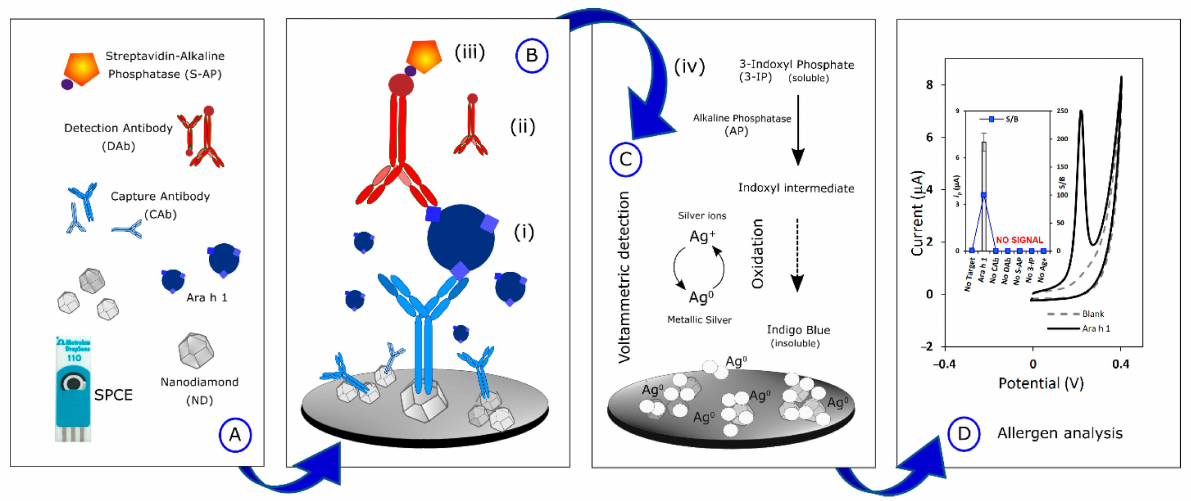
Figure 2. Scheme of the sensor assembly ( A ), the sensing mechanism ( B ), and the allergen detection ( C , D ) Allergen electrochemical detection. Reprinted from